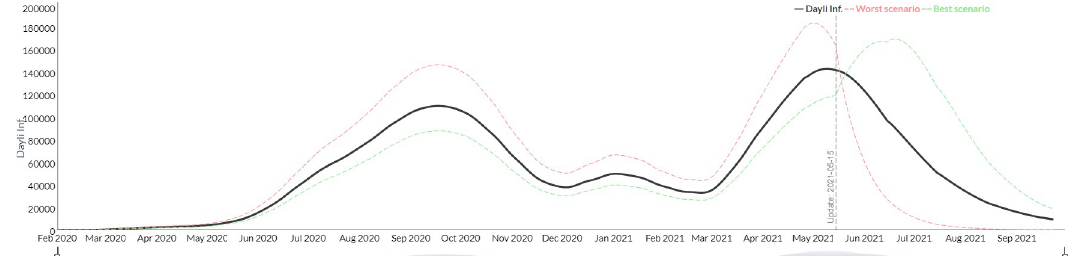
Fig 5. Simulation of the evolution of the new daily infected from July 2020 to September 2021 with reduction gradual intervention (Argentina).